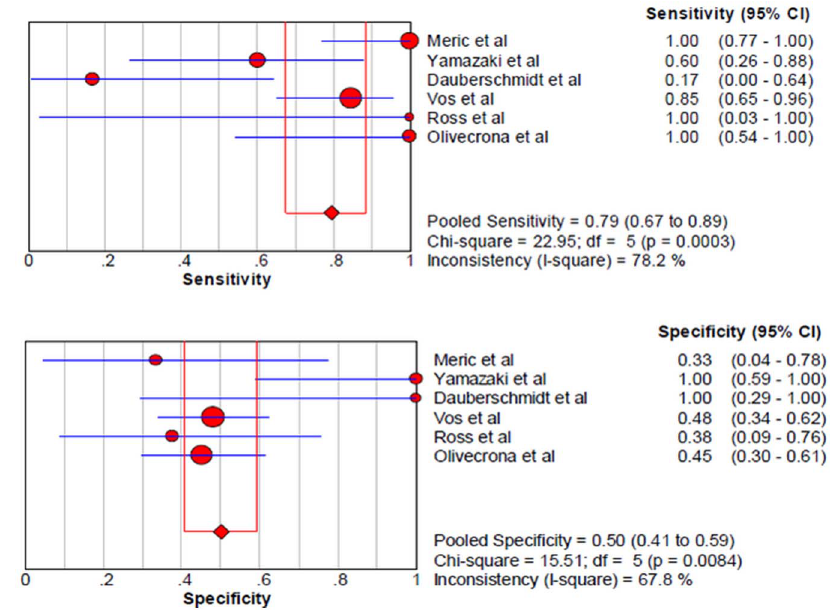
Figure 8. The pooled sensitivity and specificity to predict mortality in patients with traumatic brain injury.